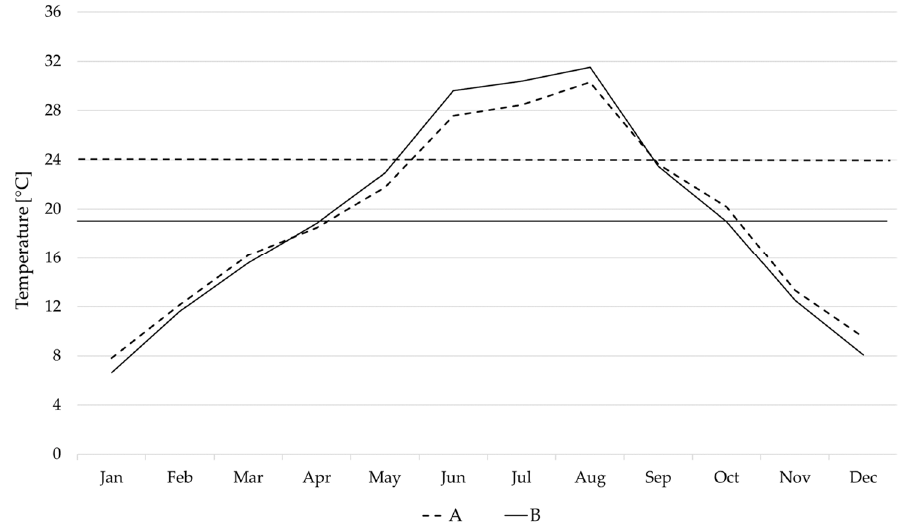
Figure 11. Trend of monthly and annual (horizontal line) mean values of T for Lungarno (A) and Ponte Vecchio (B).